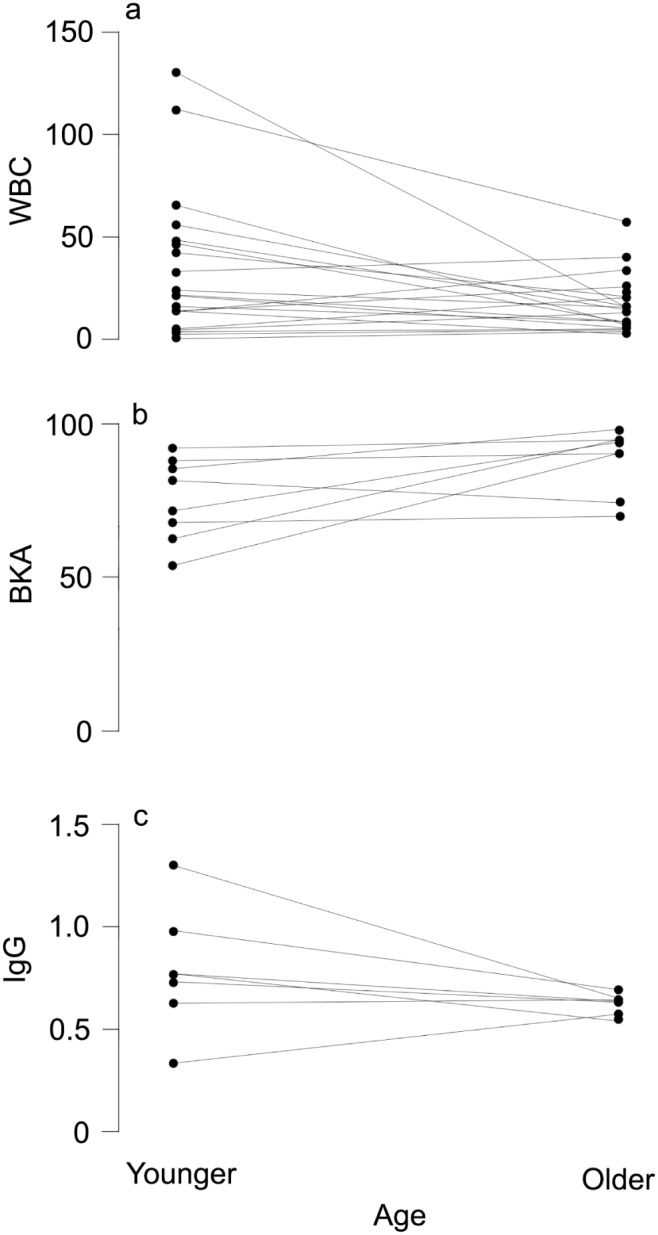
Changes in immune parameters within individual S. bilineata.Data of the same individual are connected via a solid line. White blood cell (WBC) count decreased with age (a) while there was no change in bacterial killing ability (BKA) of the plasma (b) and immunoglobulig G (IgG) concentration (c).